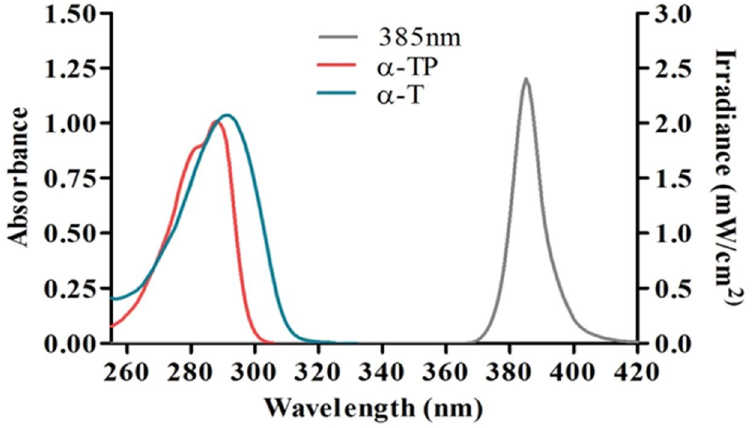
Figure 1. The emission spectrum of the 385 nm UVA1 source (dotted line) and the absorbance spectra test compounds (400 µM) in methanol (solid lines). α-TP and α-T show absorbance peaks in the UVB region at 288 nm and 291 nm, respectively. This excludes any photoprotection by optical filtration.